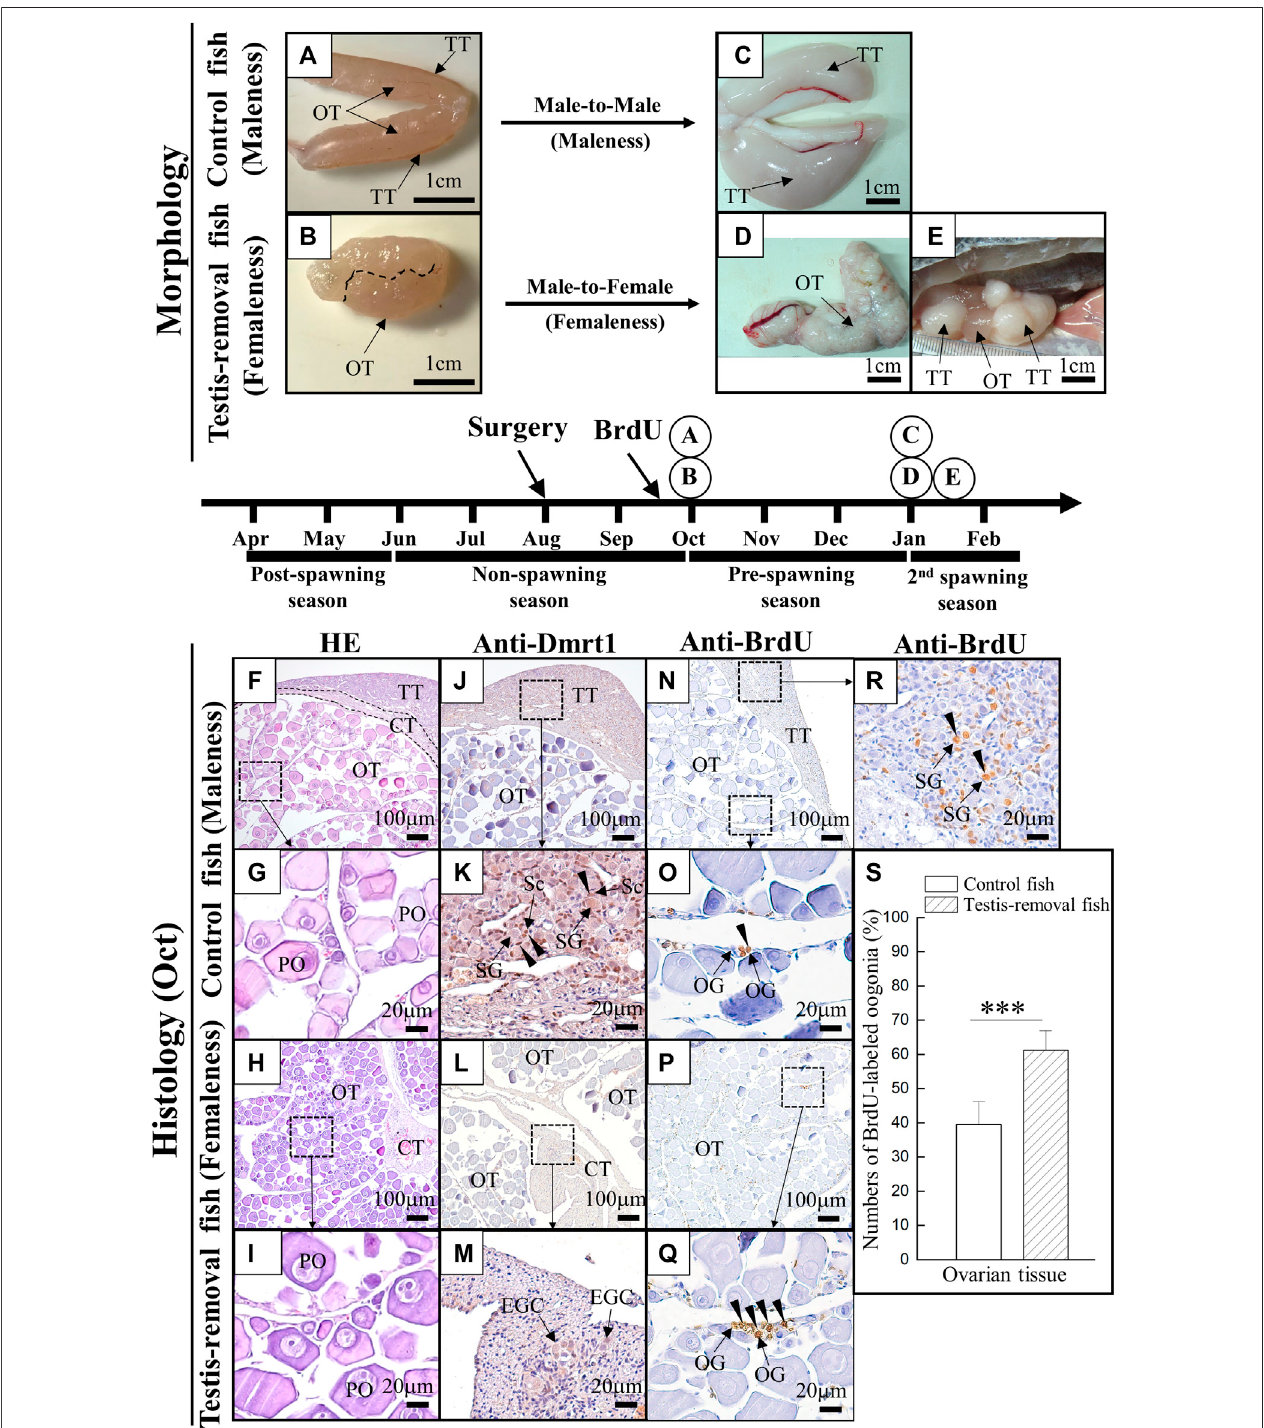
FIGURE 2 | The morphology and histology analysis during testis removal-induced sex change in black porgy. In 1-year-old fi sh, testis excision was performed during the non-spawning season (Aug). We collected gonad during the pre-spawning season (2 months after surgery, Oct) for cell proliferation/histology (F – S) and secondspawningseason(Jan)formorphologicalanalysis (A – E) .Forcellproliferationassay,BrdU(30 mg/kgBW)wasinjectedonDay7andDay3beforegonadaltissue was collected (2 months after surgery, Oct). Sertoli cell-expressing Dmrt1 was used to identify the testis-removed fi sh has a remnant testicular tissue or not. The gonad of control fi sh (A) and testis-removed fi sh (B) were collected at 2 months after surgery. The dash line (B) represents the branch of the pair gonad. The gonad of (Continued ) control fi sh (C) and testis-removed fi sh (D) were collected during the second spawning season. (E) The testis-removed fi sh has a remnant testicular tissue